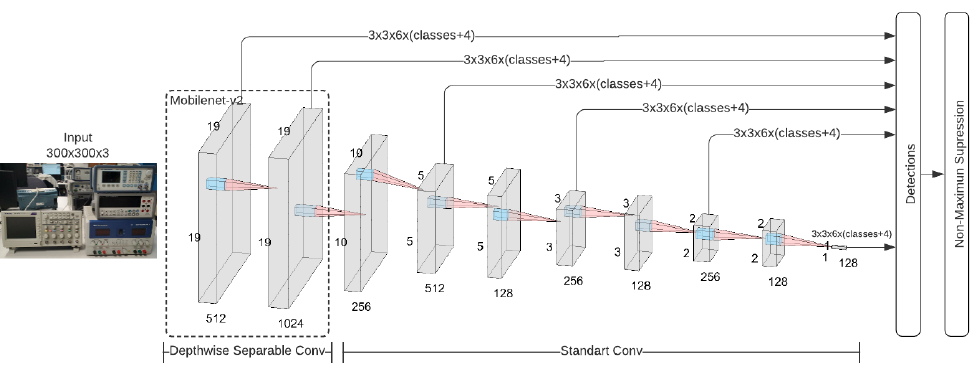
Figure 3. MobileNet SSD deep neural network